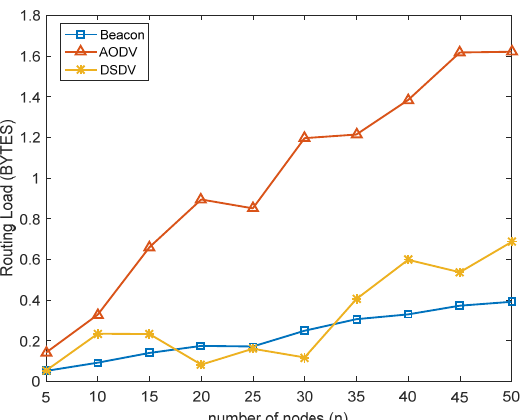
Figure 8. Routing load of beacon-based routing and the AODV and DSDV protocols.